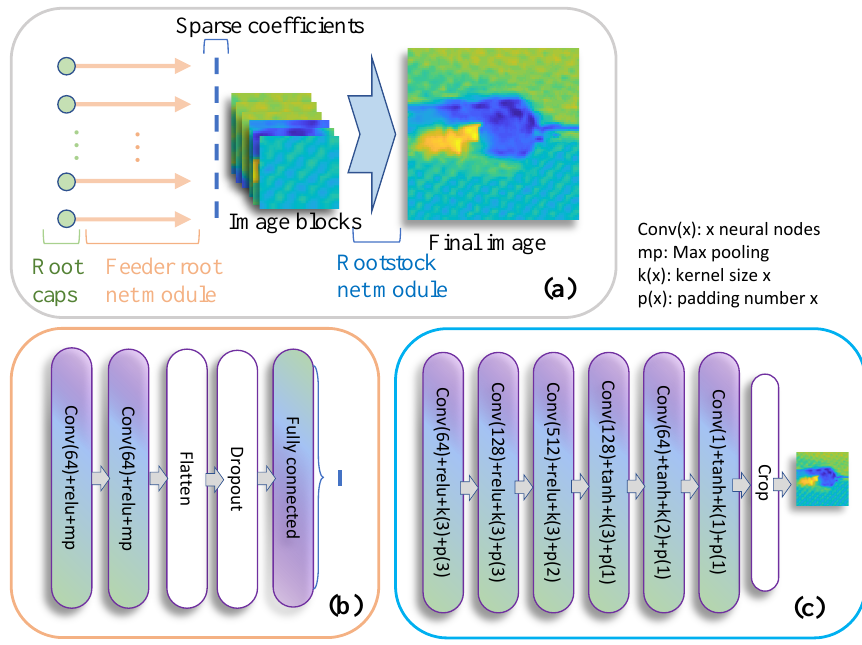
Figure 5. The structure of RootsNet. ( a ) The overall structure; ( b ) The feeder root net module; ( c ) The rootstock net module.